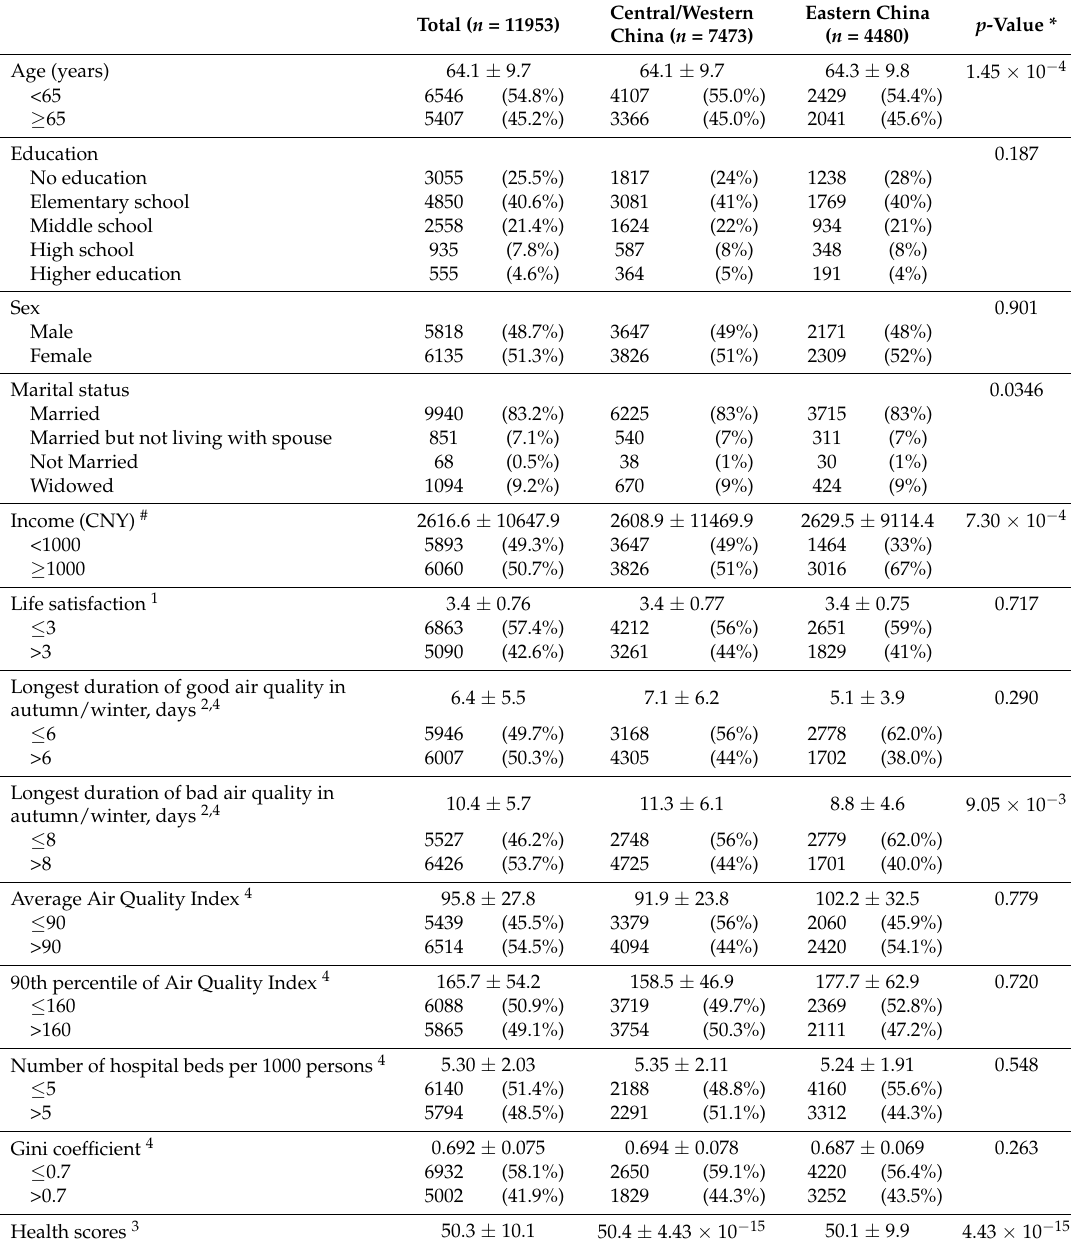
Table 1. Demographic characteristics of participants by